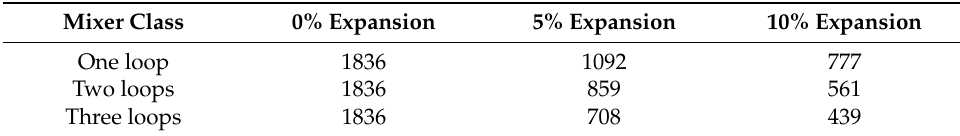
Table 5. Peclet number at the widest cross section of the channel ( Re 1.0).